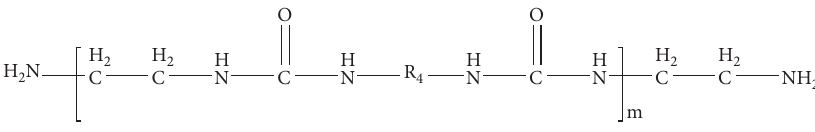
Figure 2: Side chain’s reaction and its molecular